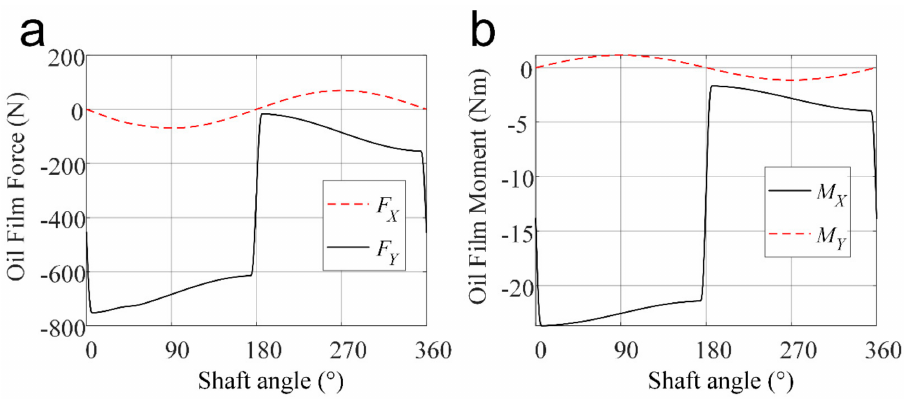
Figure 9. The oil film forces and moment acting on the piston: ( a ) The resultant oil film forces, and ( b ) the resultant oil film moments acting on the COM of the